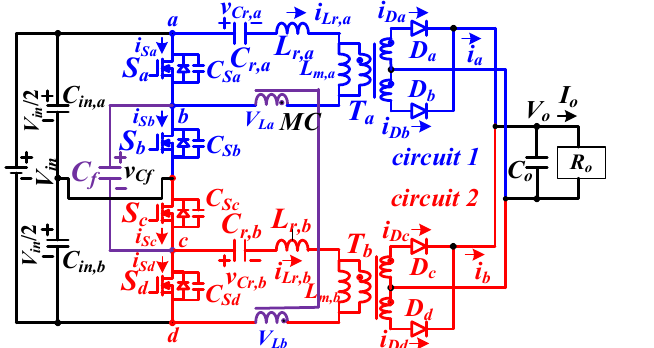
Figure 3. Circuit schematic of the inductor–inductor–capacitor ( LLC ) converter with series–parallel structure.